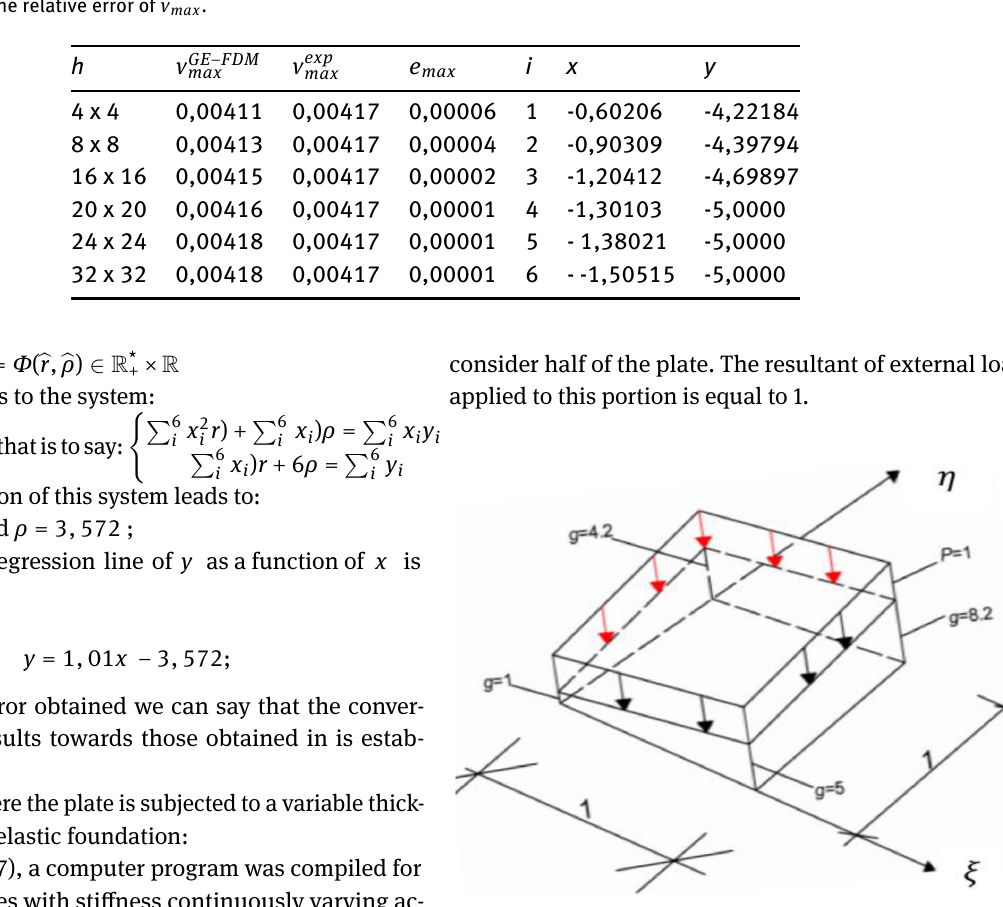
Figure 4: Square plate of variable stiffness with